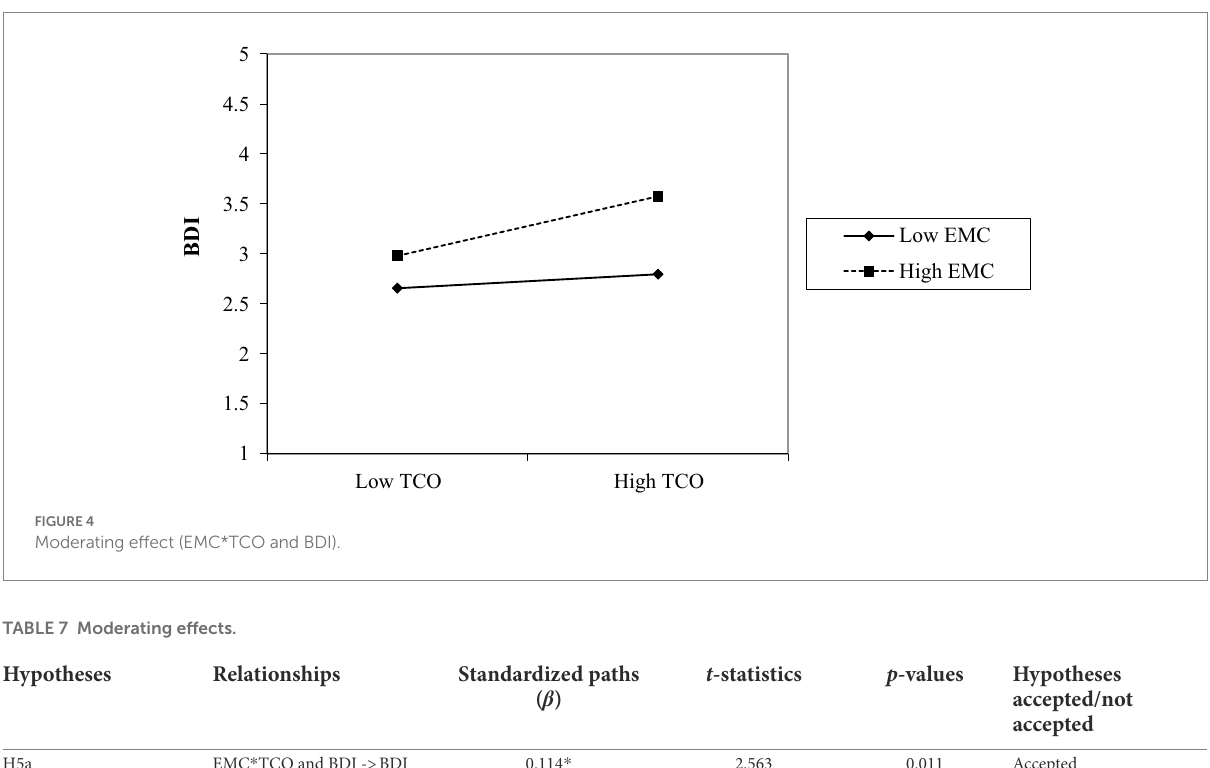
TABLE 7 Moderating